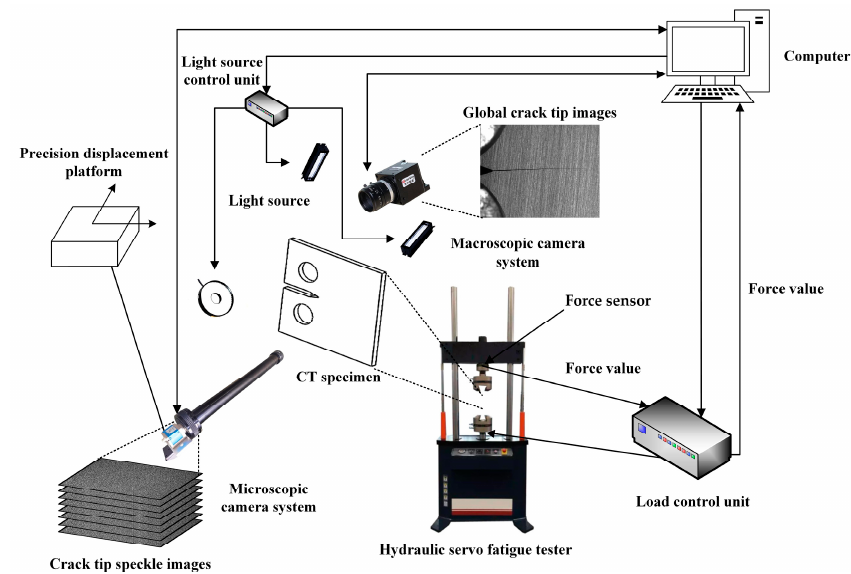
Figure 5. In situ measurement system components.